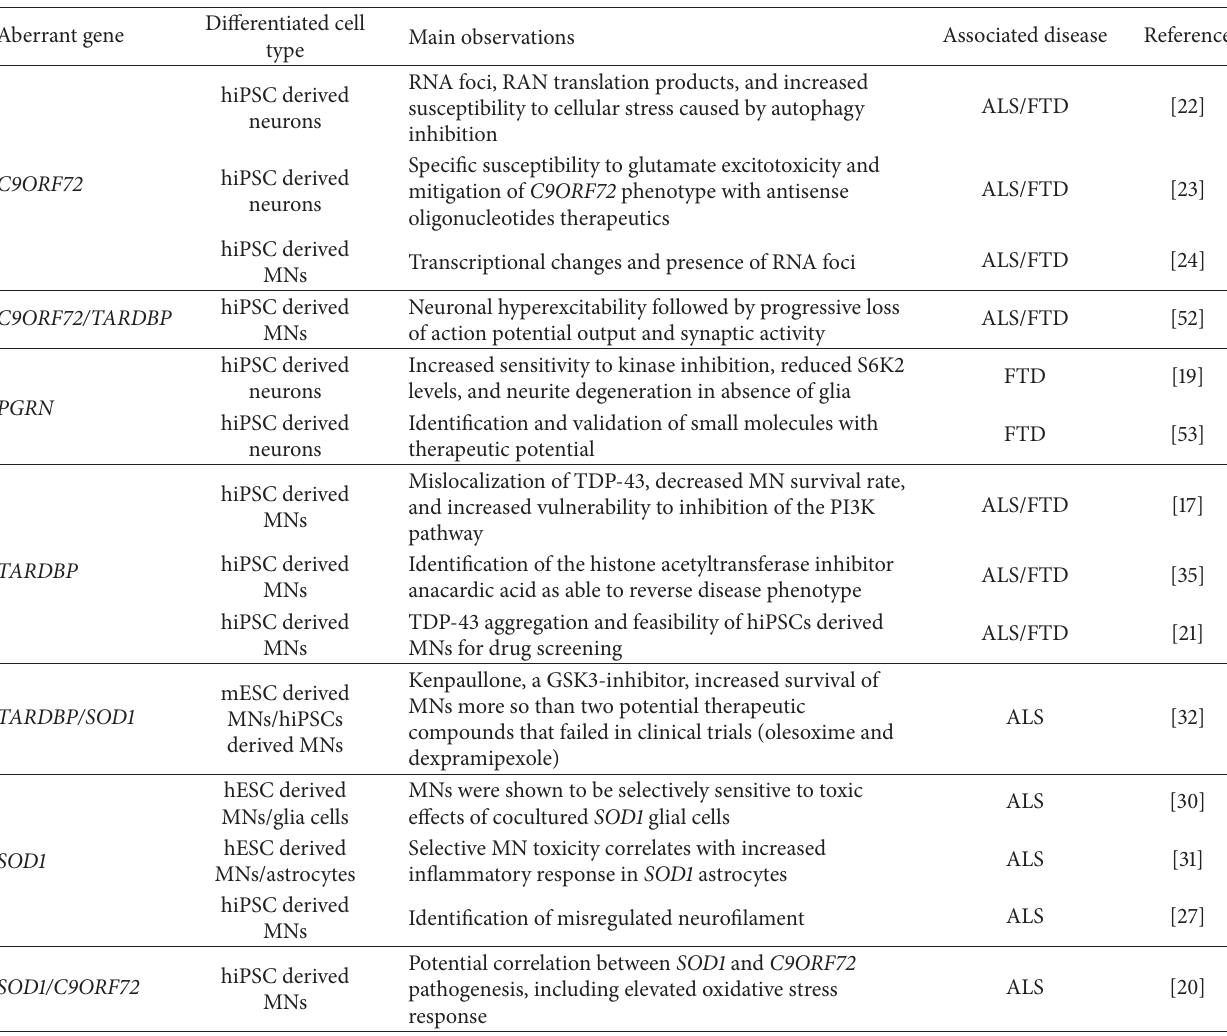
Table 2: Observations from stem cell derived models of known ALS/FTD